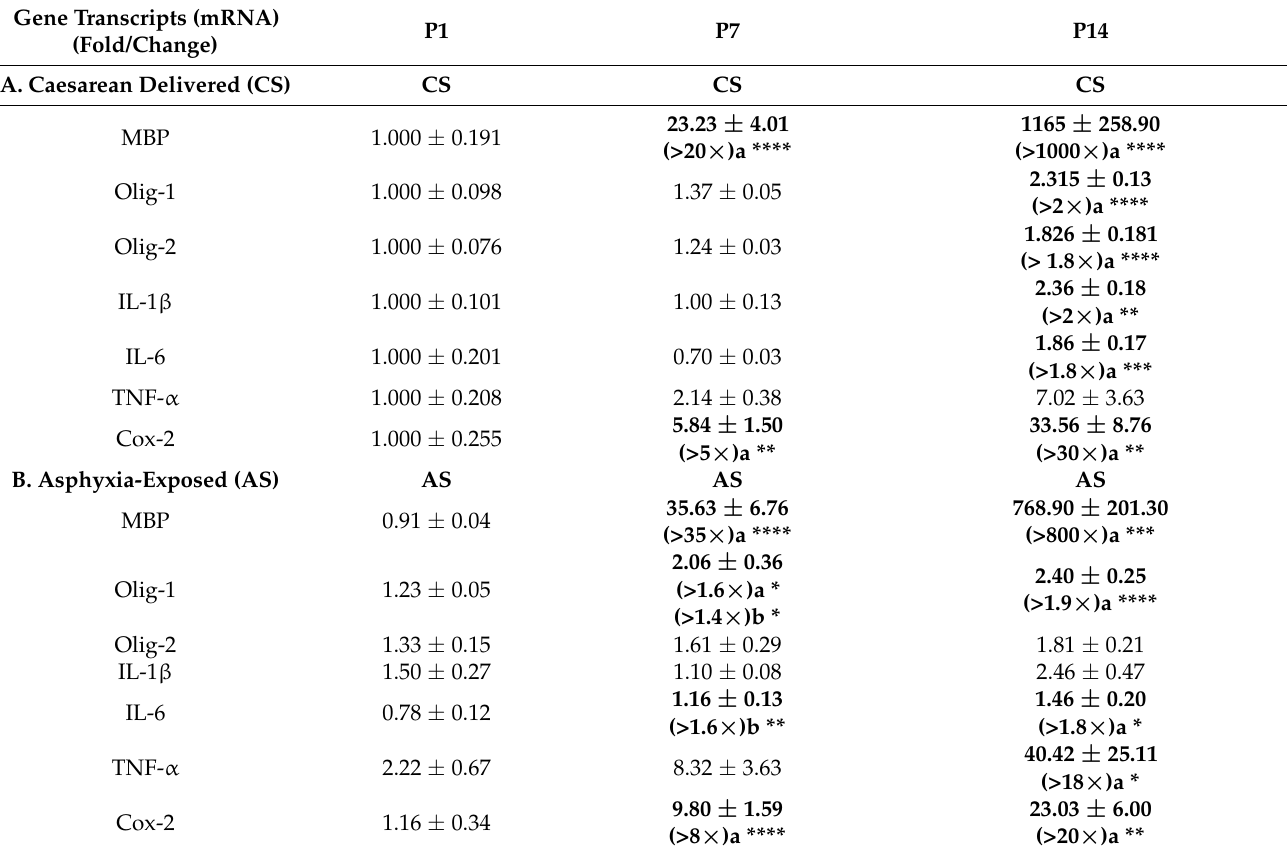
Table 3. Effect of neonatal development and perinatal asphyxia (PA) on mRNA levels of myelin basic protein (MBP), Oligodendrocyte transcription factors (Olig-1, Olig-2), and proinflammatory cytokines (IL-1 β , IL-6, TNF- α , COX-2) evaluated in telencephalon from control (CS) and asphyxia-exposed (AS) rats at P1, P7, and P14. The effect of PA on MBP, Olig-1, Olig-2, and pro-inflammatory cytokines mRNA levels (a.u.) was determined by quantitative RT-qPCR analysis. Target genes were normalized by the housekeeping ( β -actin), expressed as fold/change for each experimental group, compared to that evaluated at P1 in CS. Data are shown as means ± S.E.M., for independent experiments (at least n = 5). Unbalanced two-way ANOVA indicated a significant effect of postnatal days ( A ), and PA ( B ). MBP (F(4, 23) = 16.626, p < 0.0001); Olig-1 (F(4, 25) = 11.992, p < 0.0001); Olig2 (F(4, 26) = 5.573, p < 0.01); IL-1